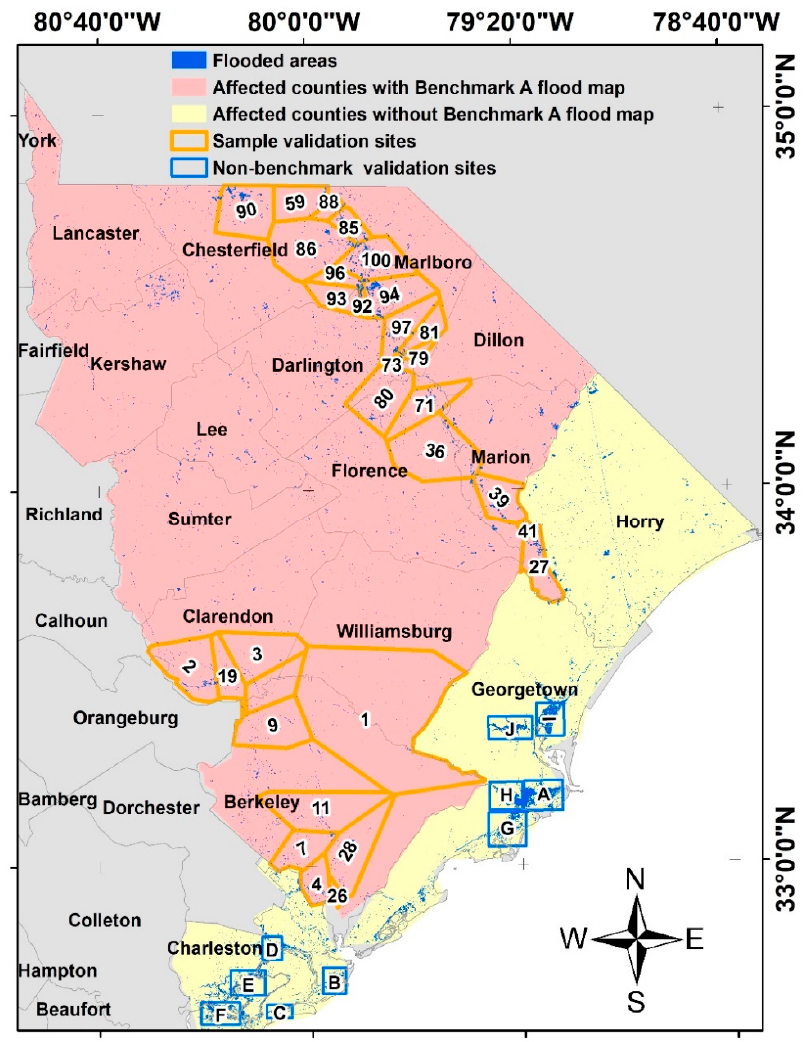
Figure 6. Sampling sites (30 randomly selected sites from 100 Thiessen generated polygons) and application sites (10 selected coastal sites labeled A to J).